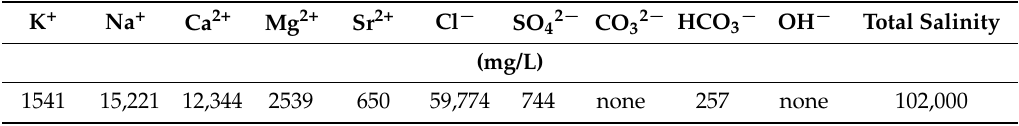
Table 1. Mineral composition of the water sample in experiments.